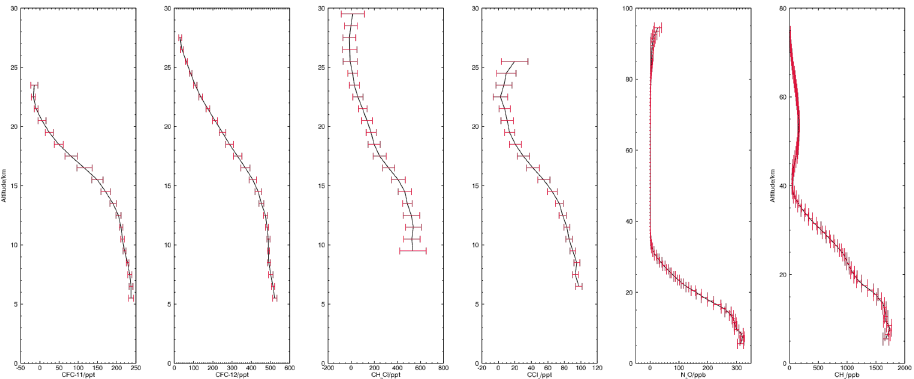
Figure C12 The mean vertical profile of CFC-11, CFC-12, CH3Cl, CH4 & N2O, calculated using data from 2009 between 75° and 90° South Fig. C13. The mean vertical profile of CFC-11, CFC-12, CH 3 Cl, CCl 4 , N 2 O and CH 4 , calculated using data from 2009 between 75 ◦ and 90 ◦